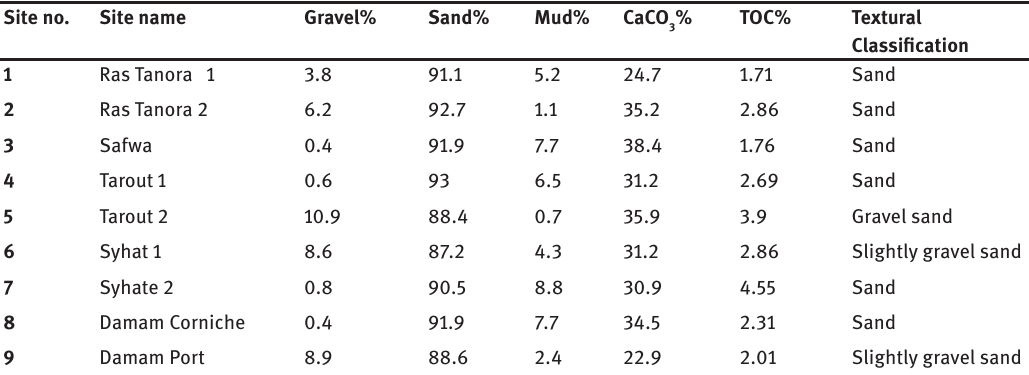
Table 1: Sediment characteristics for the studied mangrove stands along Arabian Gulf. Site